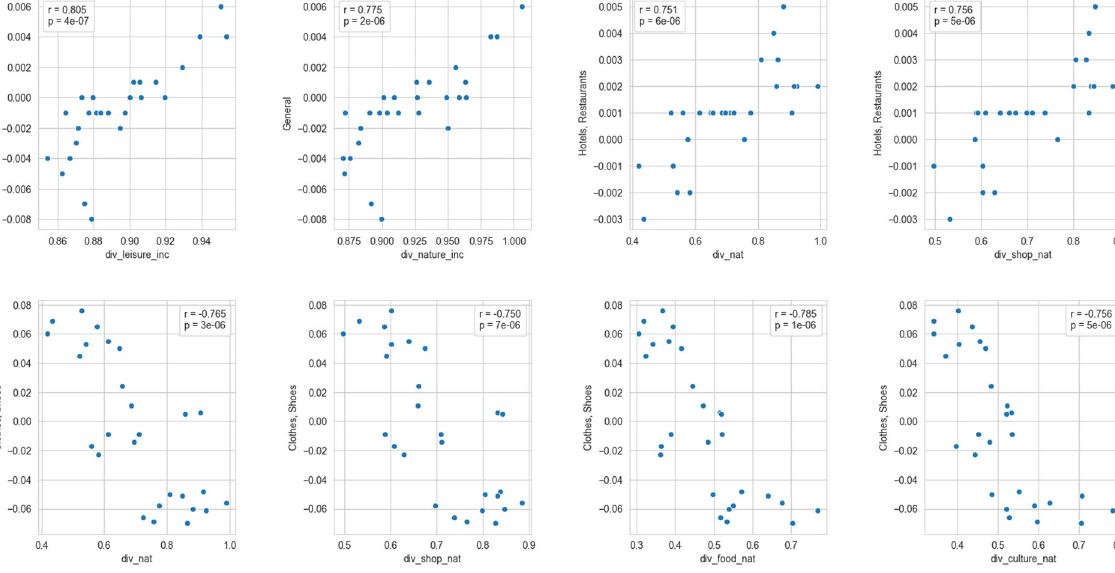
Fig. 4 Scatter plot of diversity measures and CPI measures of the top eight by the coef fi cients. The x -axis and y -axis correspond to diversity measures and CPIs,